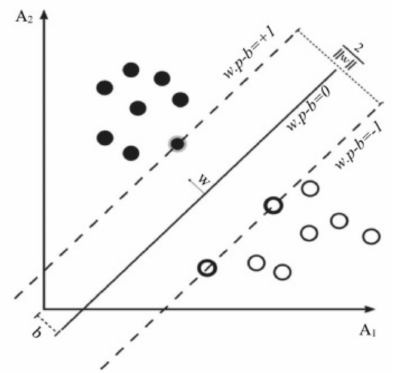
Figure A4. Hyperplane classification for the training dataset with weight (w) and bias (b)